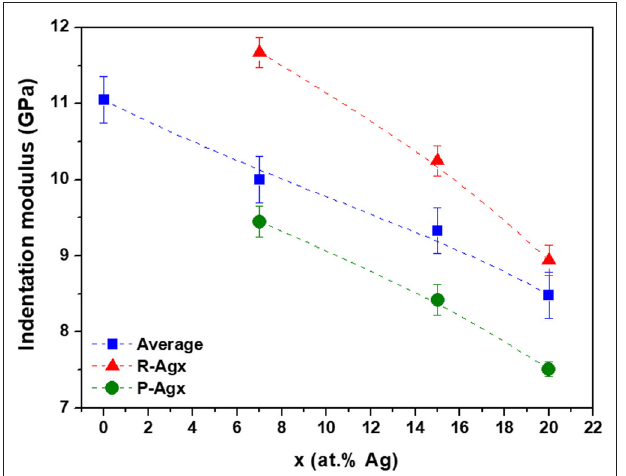
FIGURE 5 | Indentation moduli for bulk Ag x (Ge 0.25 Se 0.75 ) 100 − x glasses. Blue, red and green symbols correspond to the “average modulus,” R-Agx and P-Agx phases moduli, respectively. The broken lines are drawn as guides for the eye. The indentation modulus values and the error bars were calculated from: i) an average of three PF-QNM measurements and standard deviation evaluation for the “average modulus” and ii) an average of PF-QNM measurements over thirty different regions (see green and red regions in Figure 4 ) and subsequent standard deviation evaluation for the Ag-rich and Ag-poor phases.